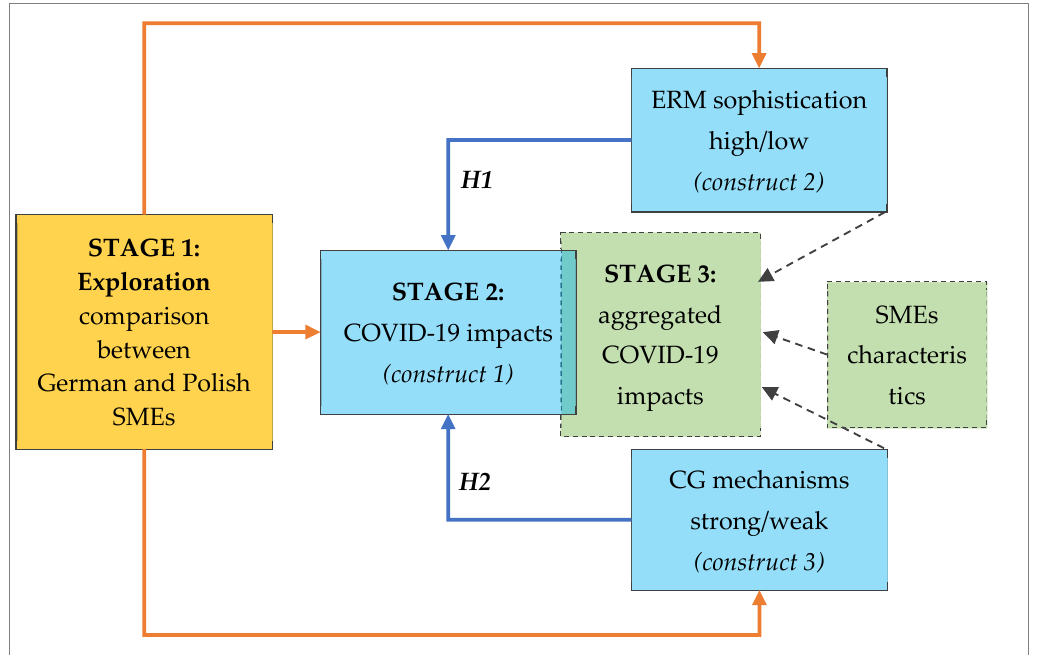
Figure 1. Conceptual map of the empirical analysis